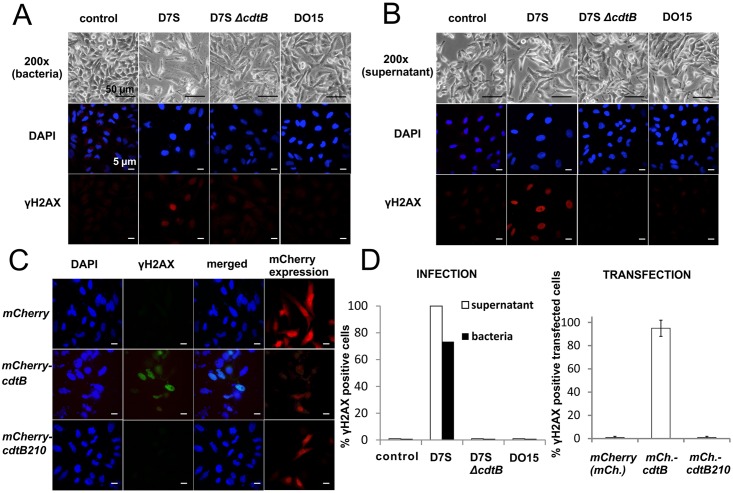
The A. actinomycetemcomitans DO15 isolate and its gene product CdtB210 are not genotoxic to eukaryotic cells.(A, B) The A. actinomycetemcomitans strains D7S, its isogenic knockout D7S ΔcdtB, and DO15 (A) or their supernatants (B) were incubated with HeLa cells. Effects on the HeLa morphology and immunocytochemistry staining for γH2AX were monitored 24 h post-infection. Cellular distention of HeLa was evident by infection with the D7S strain coding for CdtB, while the DO15 isolate harboring CdtB210 did not cause cellular distention or H2AX phosphorylation. Cell medium was used for the control. (C) Transfection of HeLa cells was performed as described in Materials and Methods. Genotoxic effects (i.e., staining for γH2AX) were observed only in cells transfected with the plasmid coding for mCherry-CdtB. (D) Quantification of the infected HeLa cells (n = 100) and transfected (two experiments with standard error, n = 90) HeLa cells, as in (A, B) and (C), respectively. Cells with more than 5 foci of γH2AX were considered positive. Genotoxicity was only seen for the D7S strain and for CdtB.